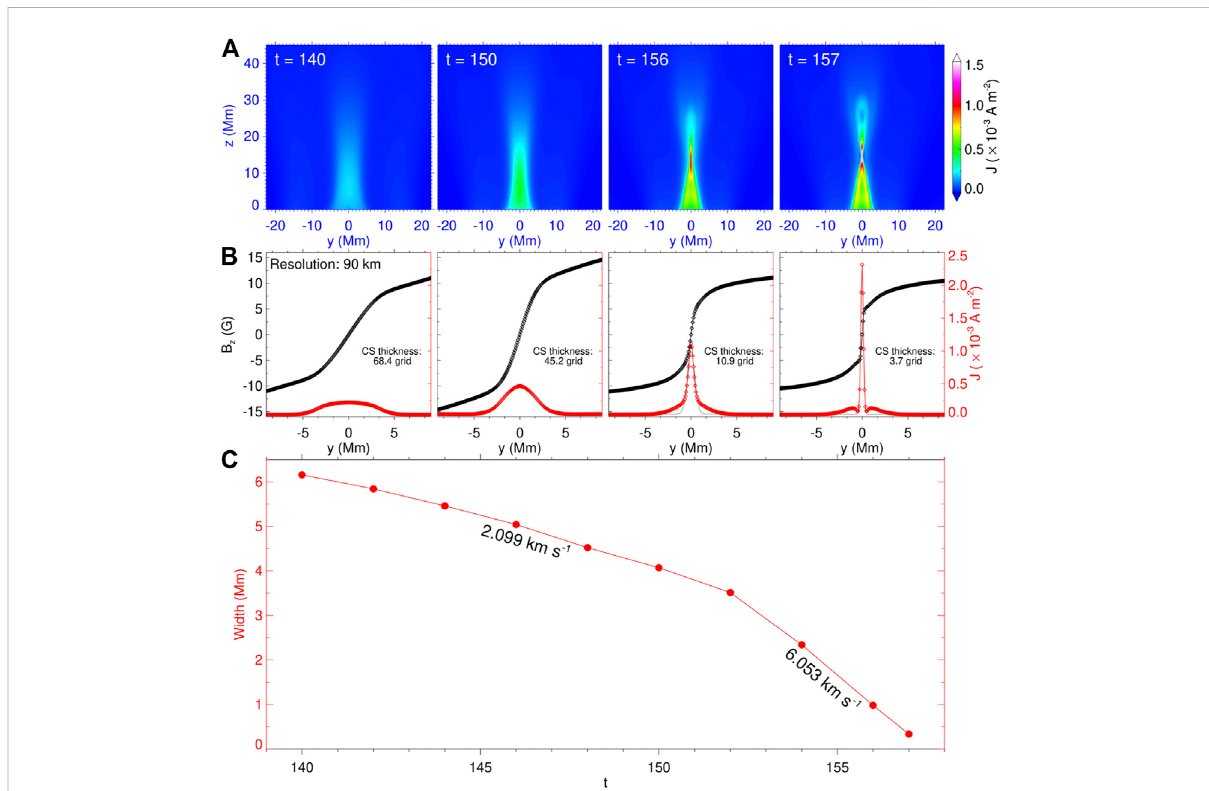
FIGURE 3 Formation of the CS. (A) Distribution of current density on the central vertical slice. (B) One-dimensional pro fi le of the vertical component of magnetic fi eld B z andcurrentdensity J alongahorizontallinecrossingperpendiculartothepointwiththemaximum (J) .Thediamondsdenotevalues on thegridnodes. The thickness ofthe CSisdenoted, which isde fi ned bytheFWHM ofaGauss function fi tting (thethinblack curve) ofthepro fi le of current density. (C) Thickness evolution of the CS during the converging driven process as shown in (B) . The velocity at which the thickness of the CS changes is also given. The boundary between these two velocities is t =